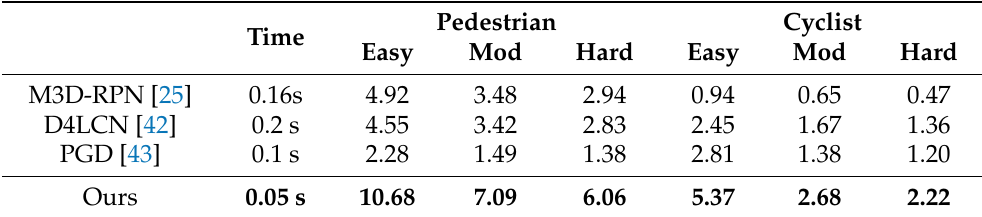
Table 2. The comparison of AP 40 between our framework and image-only 3D localization frameworks for pedestrian and cyclist on the 3D object detection task. We use bold type to indicate the best result.